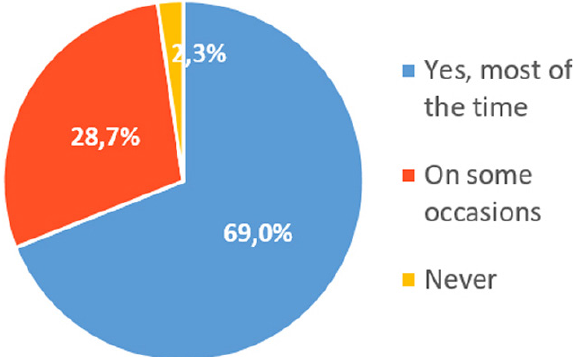
Fig. 12. Percentage of students who report that virtual workshops